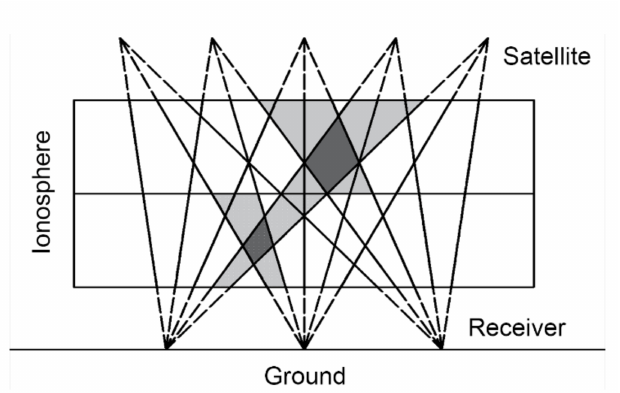
Figure 4. Diagram of the natural voxel decomposition (adapted from [27]). The light gray area is the natural voxel, and the dark gray area is their intersection part.